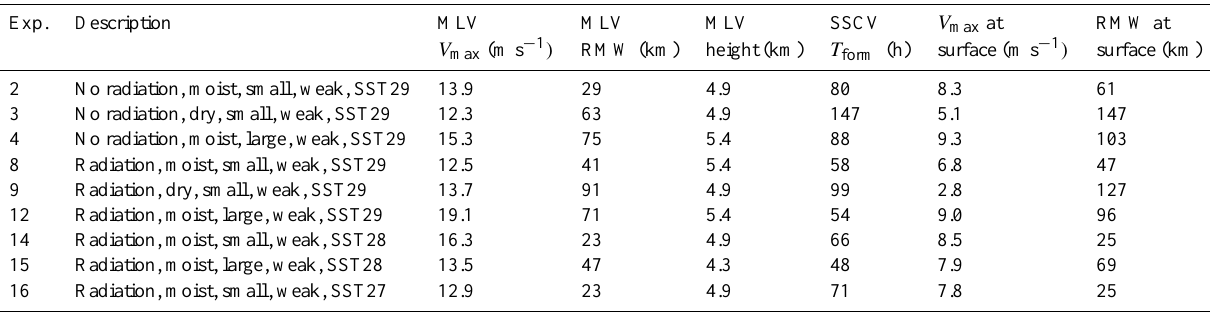
Table 3. Properties of the prominent mid-level vortex (MLV) that form for systems that develop along pathway Two: shown are the maximum azimuthally averaged tangential velocities of the MLV, its RMW and height at the time the SSCV forms; the time the SSCV forms; the maximum near-surface tangential winds and the near-surface RMW, at this